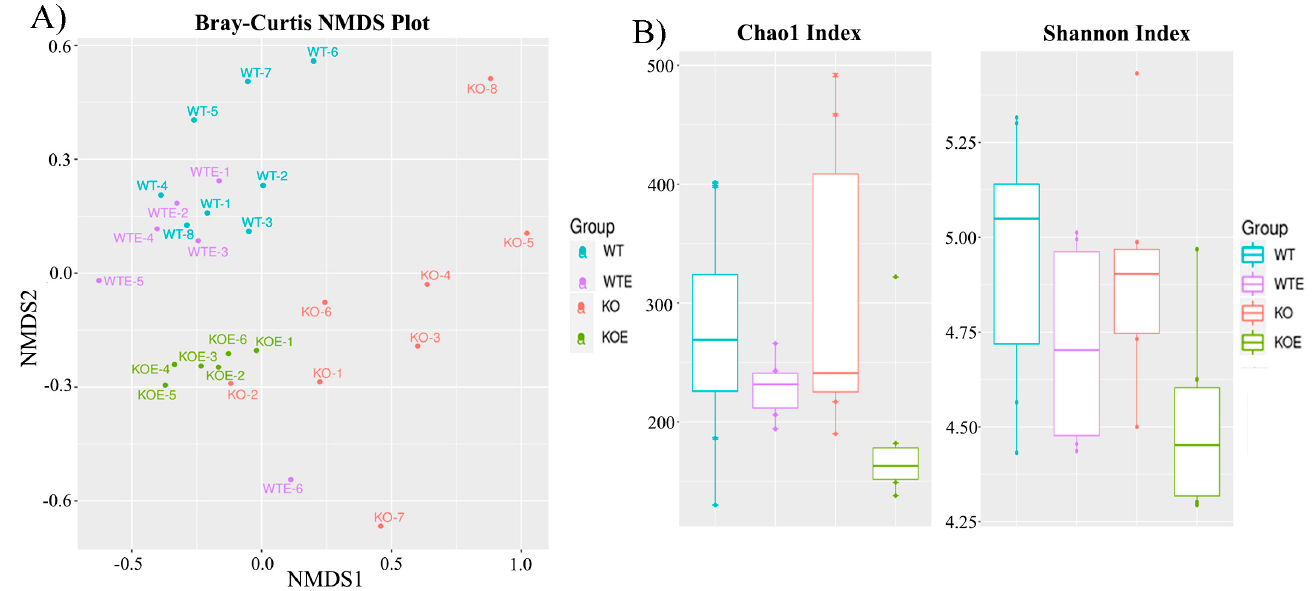
Figure 3. Bray–Curtis NMDS plot of fecal samples, showing that ethanol treatment results in lower species richness and phylogenetic diversity. ( A ) The fecal microbiota of the four groups showing three differentiated clusters. ( B ) Bacteria diversity was analyzed using the Chao1 and Shannon indices. Microbiota alpha-diversity was lowered by ethanol consumption independently of the genotype, and lack of TLR4 had no effect on the number of species. KO vs. KOE were more different groups ( p = 0.076 and p = 0.13 in the Chao1 index and the Shannon index, respectively), whereas WT vs. KO were more similar groups ( p = 0.959 and p = 0.51 in the Chao1 index and the Shannon index, respectively). Statistics obtained according to the Mann–Whitney U test with p -values corrected by Benjamini and Hochberg, N = 6.